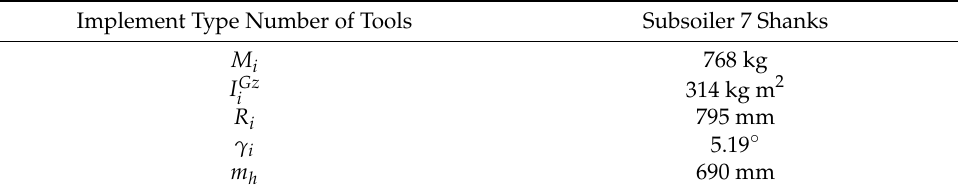
Figure 7. Model validation tests setup: a 7-shanks subsoiler is connected to the rear TPH of the tractor. Table 2. Implement used in the validation